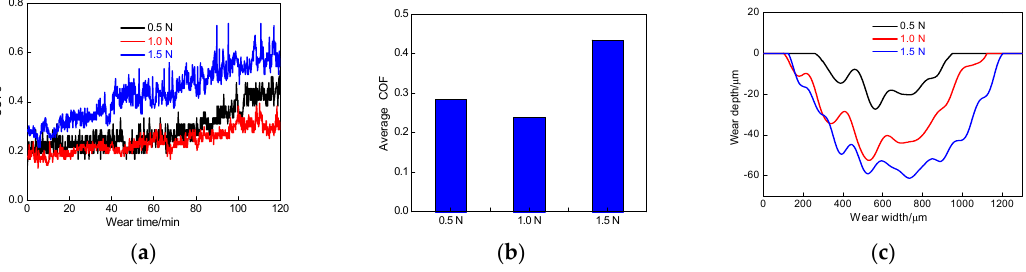
Figure 3. Coefficients of friction (COFs) vs. wear time and wear profiles of cold sprayed Al coatings before LR. ( a ) COFs vs. wear time; ( b ) Average COFs; ( c ) Wear profiles.